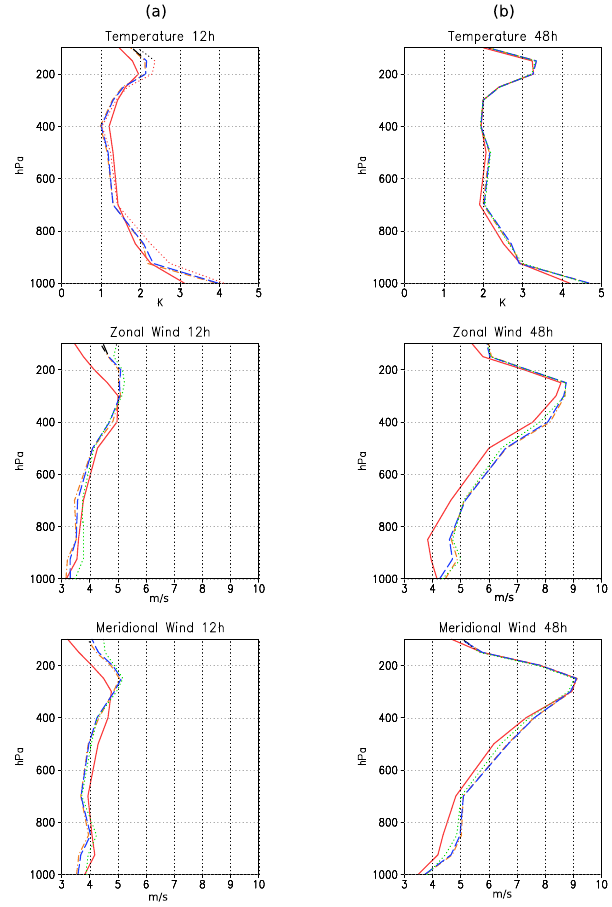
Fig. 11. Vertical profile of the root-mean-square forecast error in the limited area domain at 12-h (a) and 48-h (b) forecast time for the global forecast (red solid) and for the limited area forecasts with coupling strategies 1 (orange dashes and dots), 2 (blue dashes) and 3 (green dots) assimilating observations of the real